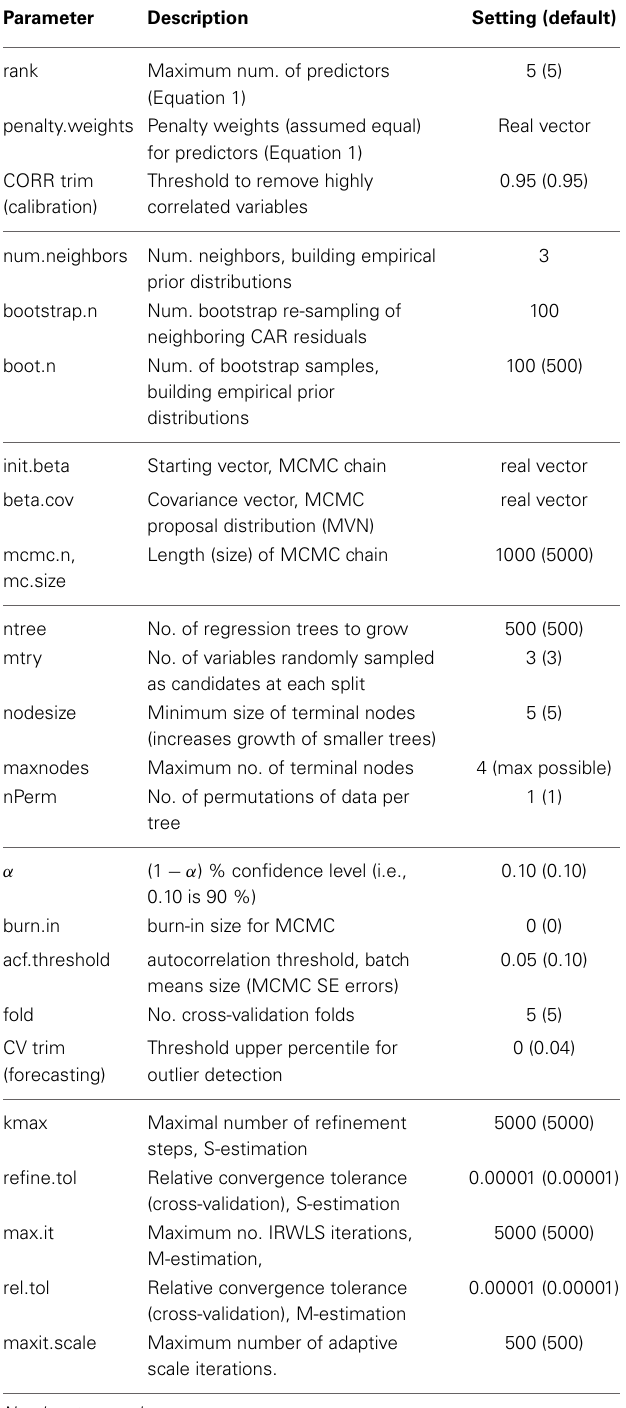
Table 2 | Leading parameters (name, R library association, description, setting) of the integrated forecasting